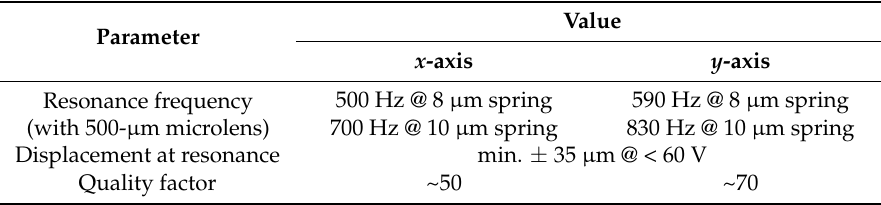
Table 2. Expected performances of the x-y scanner.